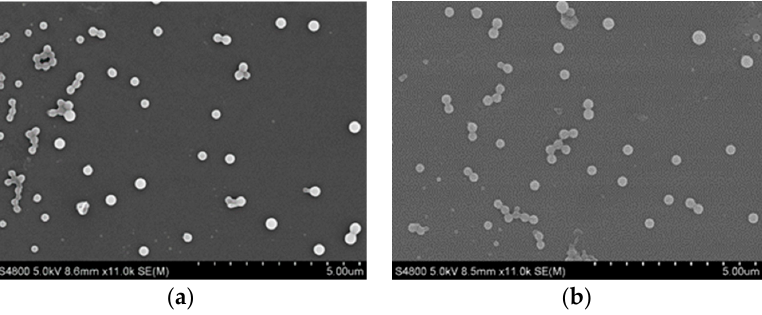
Figure 9. SEM images of ( a ) SRL nanoparticles; ( b ) SRL nanoparticles stored after 110 days.